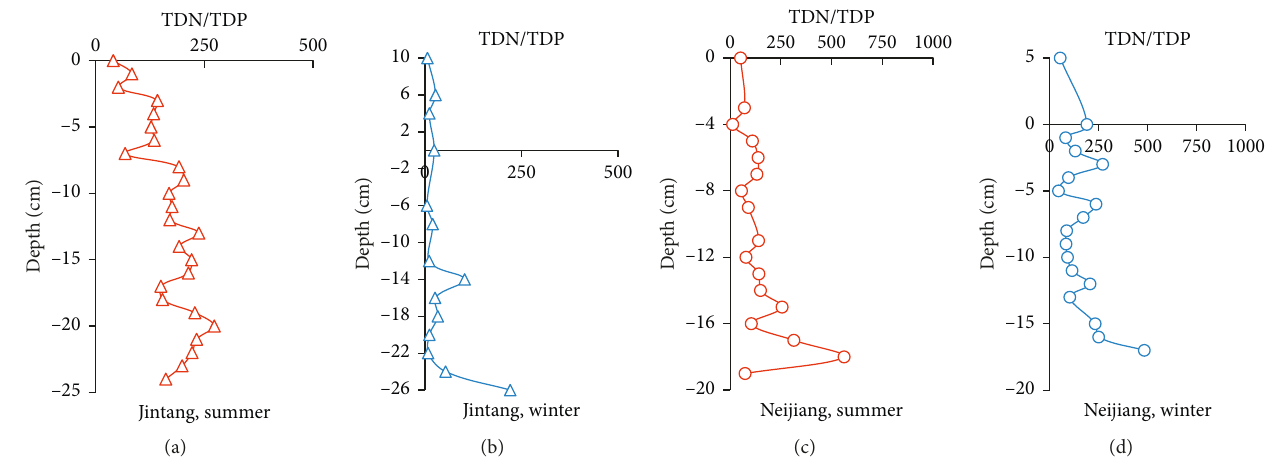
Figure 5: Vertical distributions of TDN/TDP in overlying waters at the two sampling